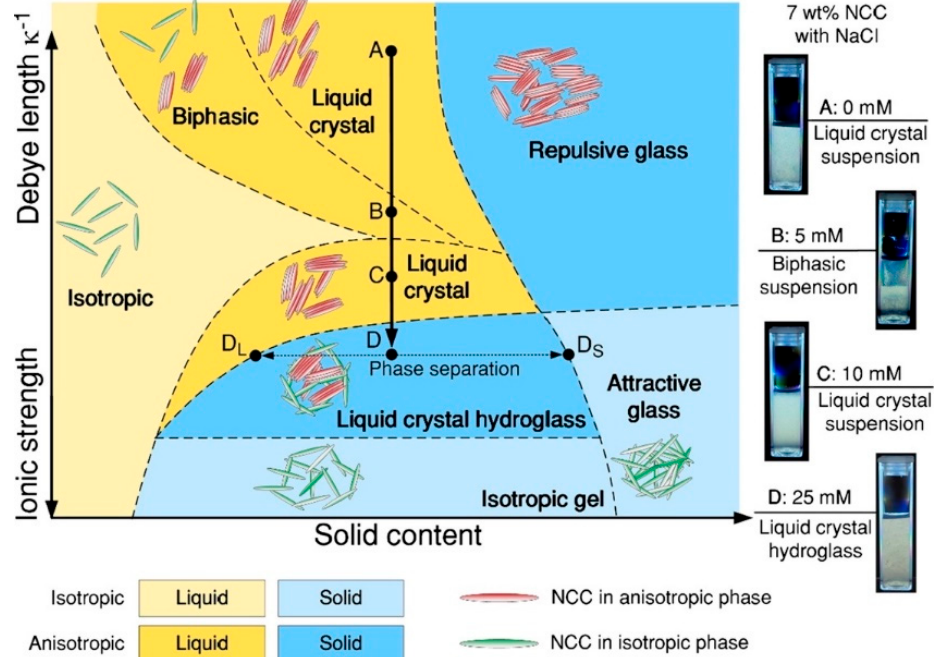
Figure 6. Schematic phase diagram of CNC aqueous suspension as a function of solid content and inter-particle attraction (represented by ionic strength). The relative positions of each phase and the geometry of the boundaries, as well as theoretical works in colloidal suspension gelation and liquid crystallinity, are from references [50,77–79]. Pictures A − D on the right were shot with cross-polarizers and corresponded to compositions A − D on the phase diagram, respectively. Reproduced from [75].